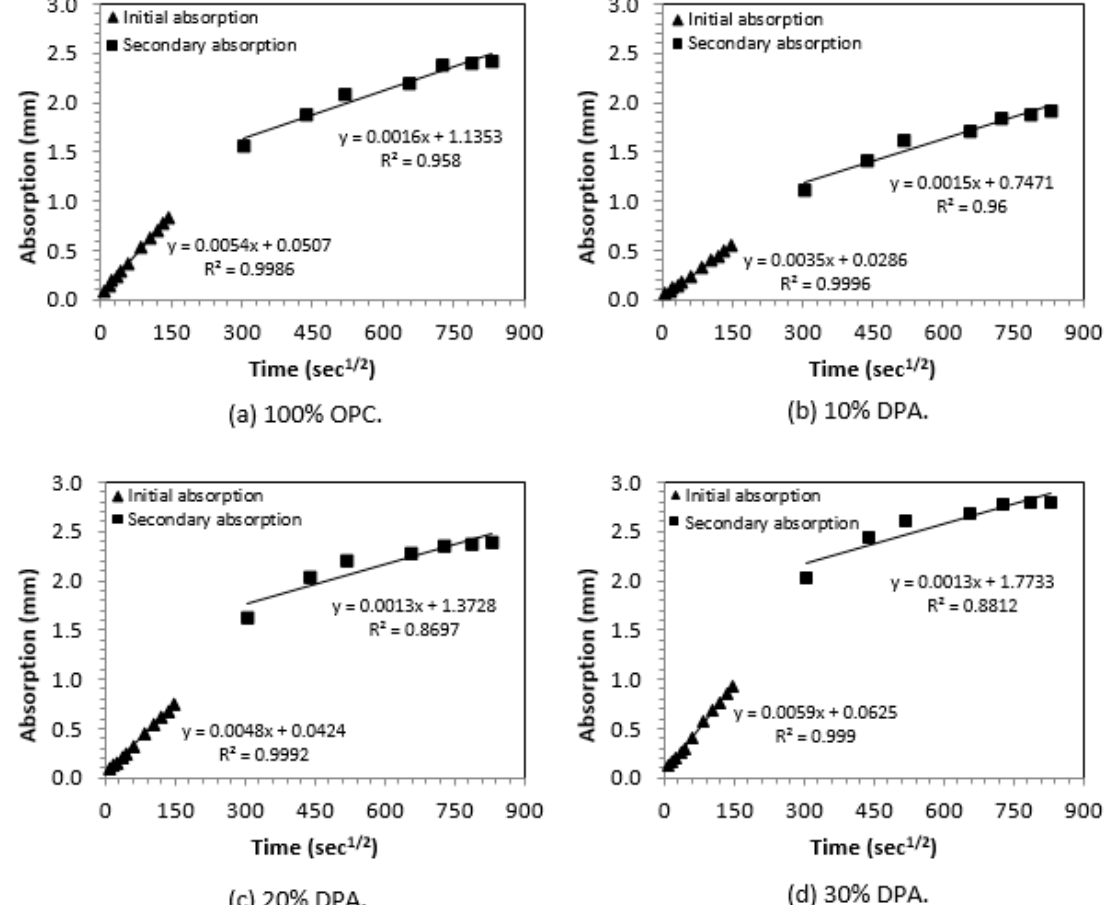
Figure 4. Correlation between rate of water absorption and time at 28 days: ( a ) 100% OPC, ( b ) 10% DPA, ( c ) 20% DPA and ( d ) 30% DPA.